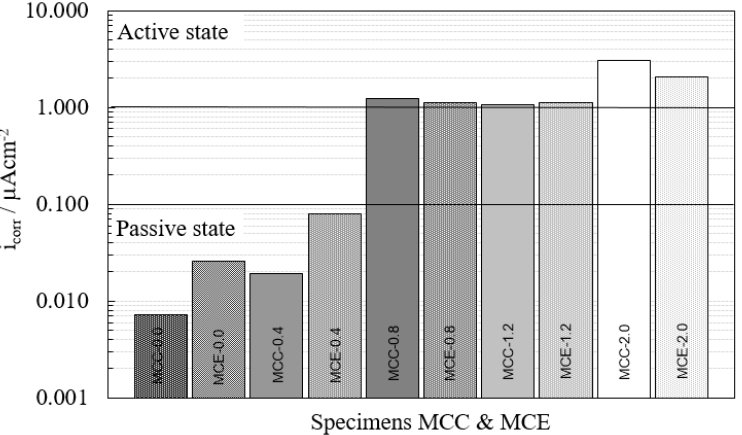
Figure 9. i corr values of test specimens attacked by chlorides, in standard test specimens (MCC) and test specimens with LFS (MCE) after 546 days.